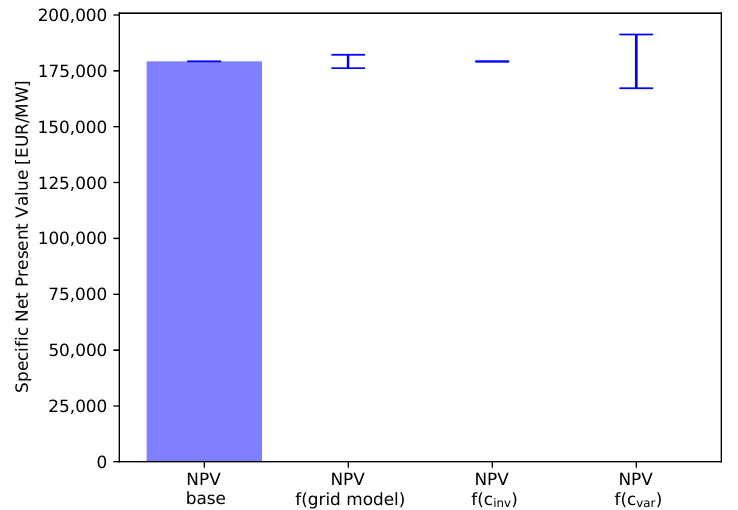
Figure 19. Influence of uncertainties in the open-source power grid model, the DR investment costs and the DR variable costs on the specific net present value for the example of the PtH in district heating technology at a grid node close to the city of Dortmund. Annotation: base = result for the reference case; f() = results for using modified input parameters based on the considered